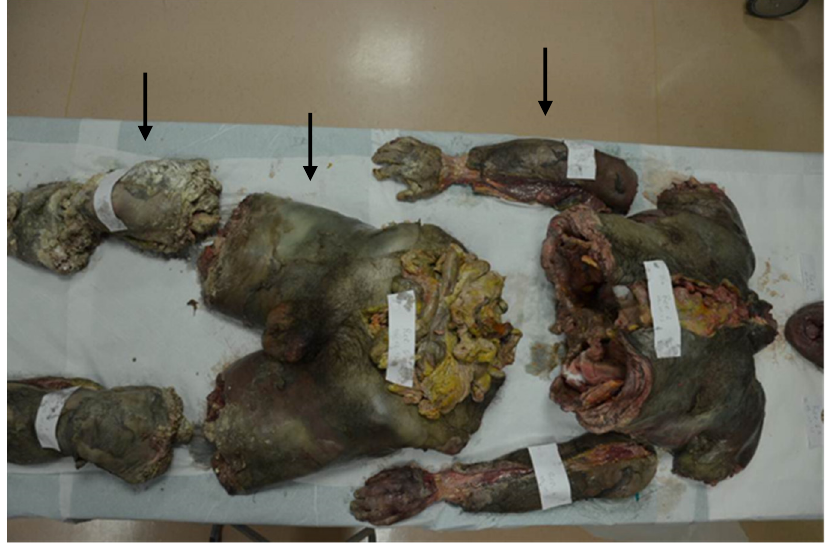
Figure 1. The body segments were analyzed and subjected to an anthropological investigation. There were no deposits of eggs found nor any presence of larvae, which assumes there was a prolonged exposure of the body before concealment.